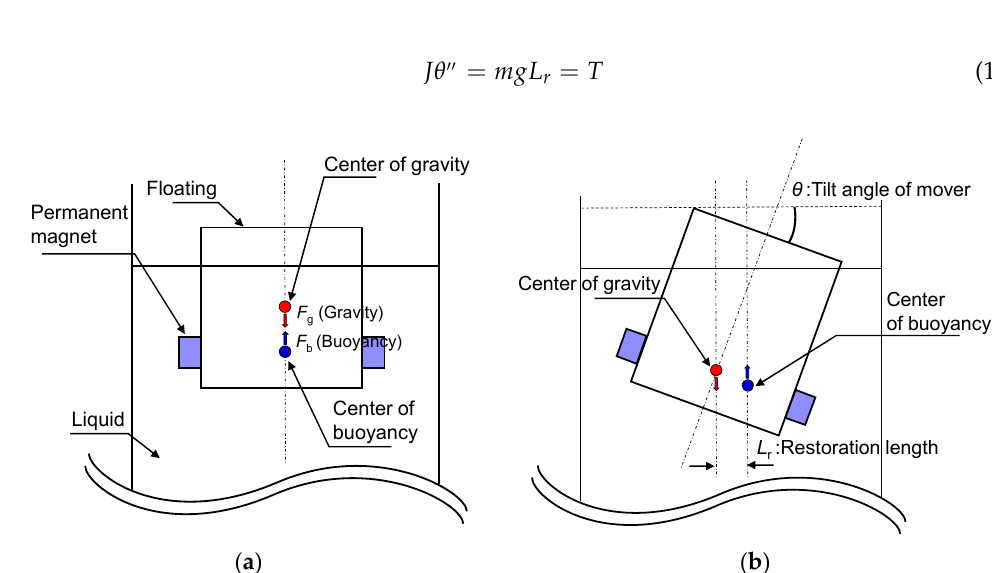
Figure 7. Force acting on the mover. ( a ) Balanced state ( θ = 0); ( b ) Tilt state ( θ ≠ 0).